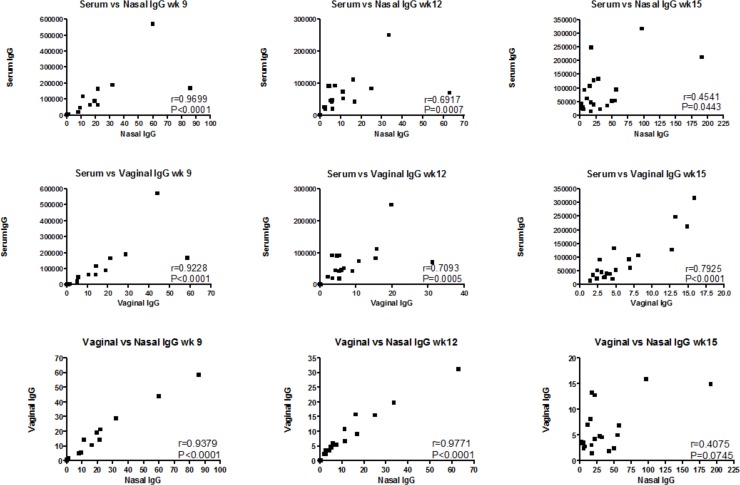
Spearman Rank correlations comparing serum, nasal and vaginal mucosal IgG.A strong positive correlation was found at week 9 and 12 between the amounts of antigen-specific antibody present at each site but this relationship was lost by the end of the vaccination regimen as the nasal compartment exhibited increased levels of specific IgG while vaccine-specific antibody decreased in the serum and vaginal vault. By week 15, 3 weeks after the final vaccinations, the IgG present in the serum and vaginal samples still correlate strongly while that in the nasal compartment exhibits little or no significant relationship.